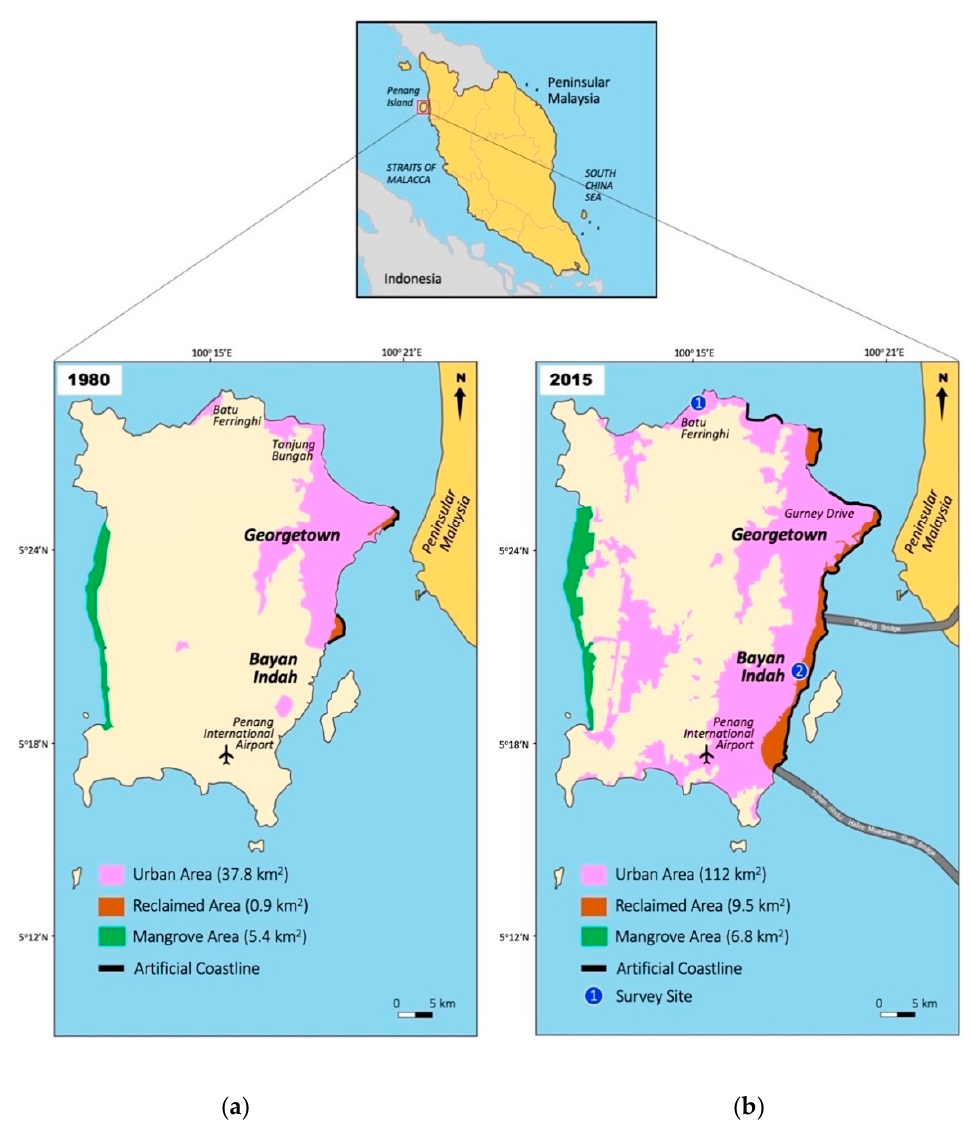
Figure 1. Maps comparing the areal distribution (in km 2 ) for the urban area, reclaimed area, mangrove area, altogether with changes in anthropogenic coastal landform (reclaimed area) for: ( a ) 1980 and; ( b ) 2015 modified from [6].